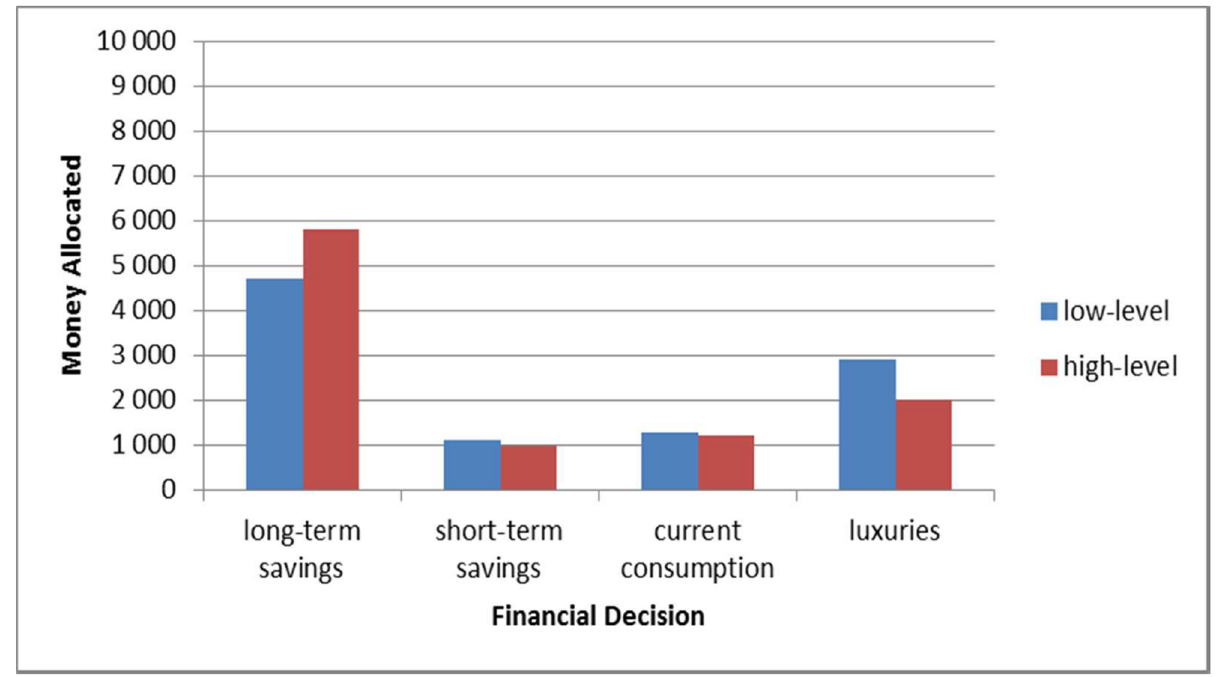
Fig 2. The amount of money allocated into financial categories by participants in concrete and abstractmind-set.